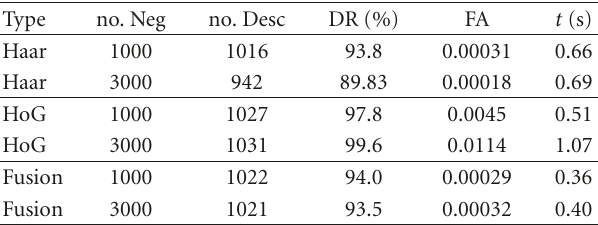
Table 3: Table of results for controlled cascade